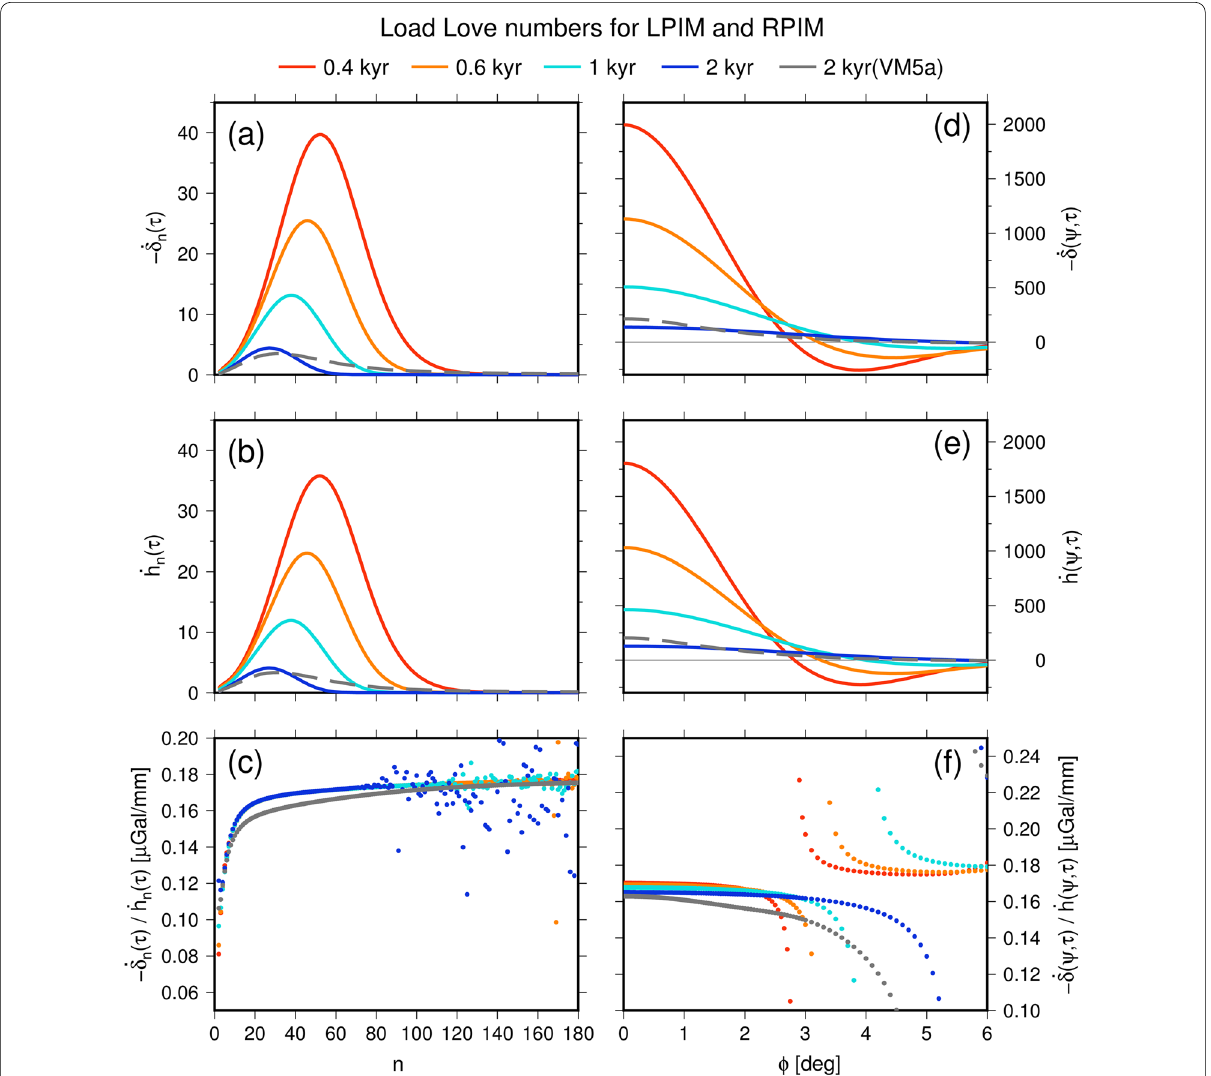
Fig. 8 Behavior of the load Love numbers used to calculate the response to LPIM and RPIM. The load Love number for τ = 2 kyr determined from the VM5a model (orange lines in Fig. 6) is shown as the gray-colored symbol in each panel, for comparison with those obtained from the subsurface ˙ h structure model (Table 3 and Fig. 7). a The variation in −˙ δ n (τ) with degree ( n ) and time ( τ ). b The variation in n (τ) with degree ( n ) and time ( τ ). c ˙ h −˙ δ(ψ , τ) with angular distance ( ψ ) and time ( τ ). e The The variation in the ratio of −˙ δ n (τ) to n (τ) with degree ( n ) and time ( τ ). d The variation in ˙ h (ψ , τ) ˙ h (ψ , τ) variation in with angular distance ( ψ ) and time ( τ ). f The variation in the ratio of −˙ δ(ψ , τ) to with angular distance ( ψ ) and time ( τ